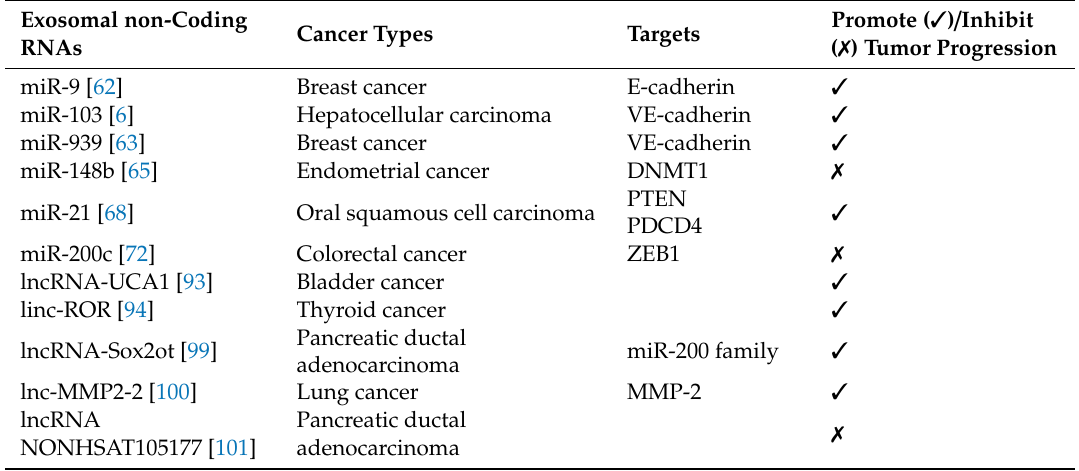
Table 1. Summary of tumor-derived exosomal non-coding RNAs mediating the instability of cadherins. Exosomal